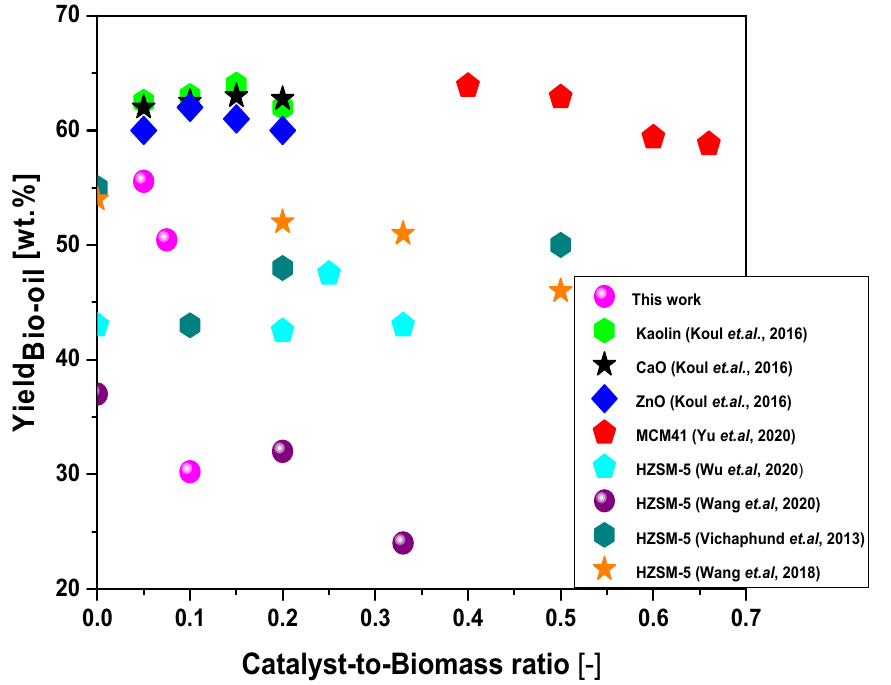
Figure 13. Effect of catalyst-to-biomass ratio within the range 0.0–0.7 on the yield of bio-oil by the